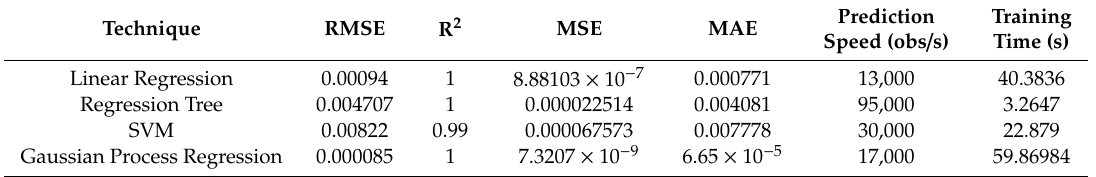
Table 4. Comparison of specific heat capacity validation results with other